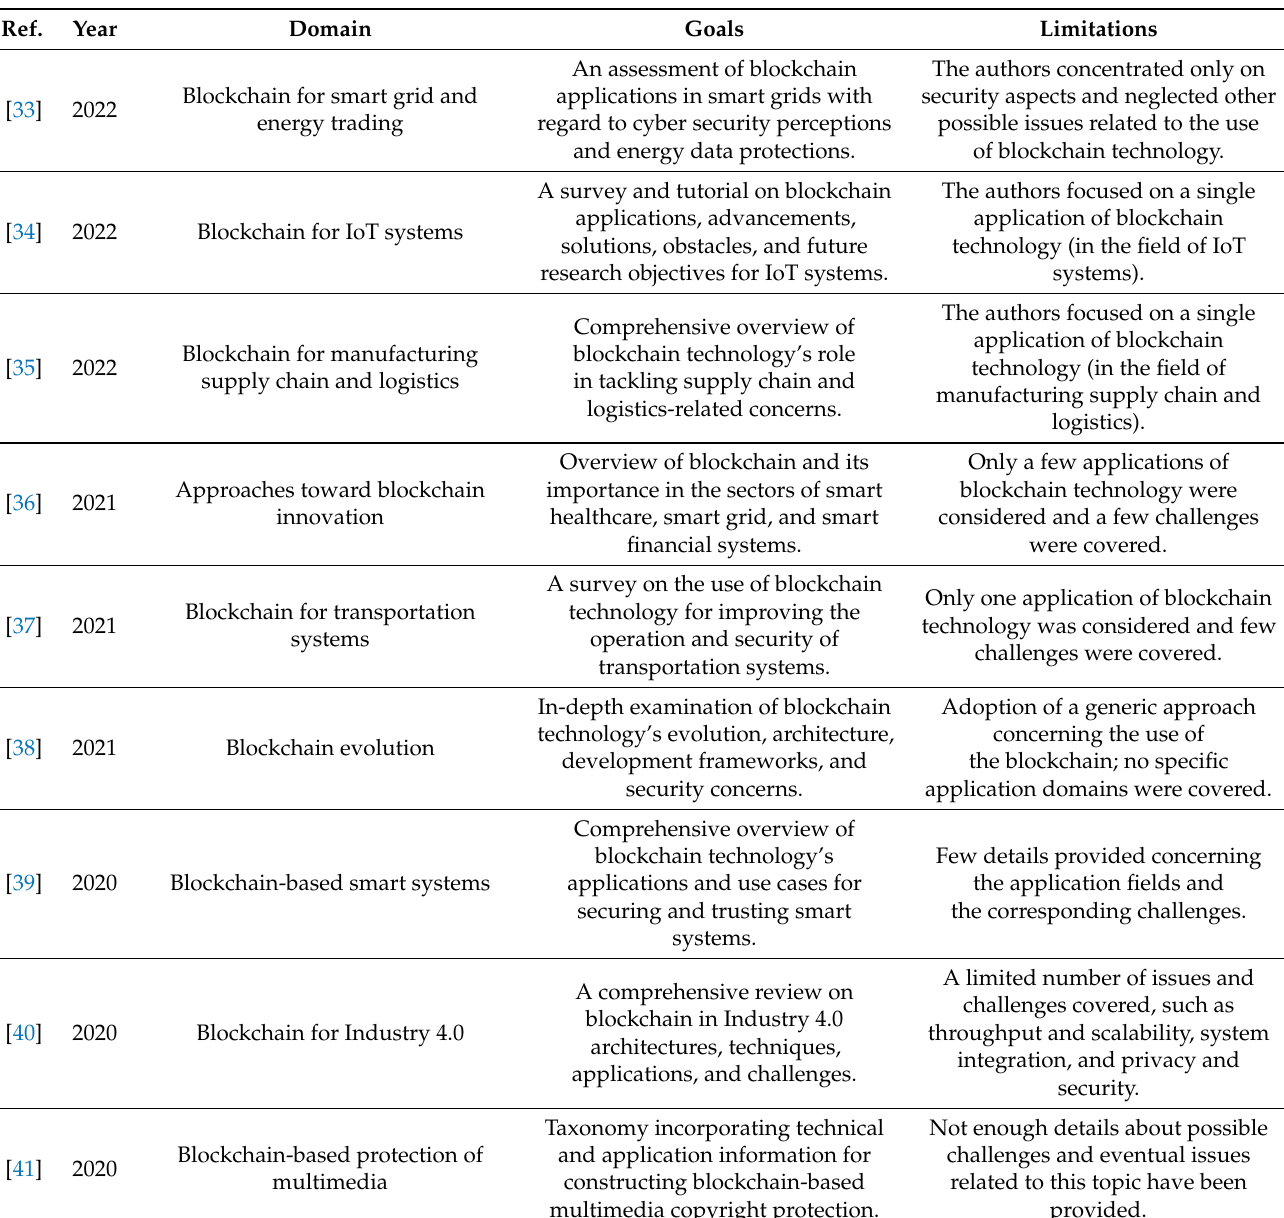
Table 2. Summary of related